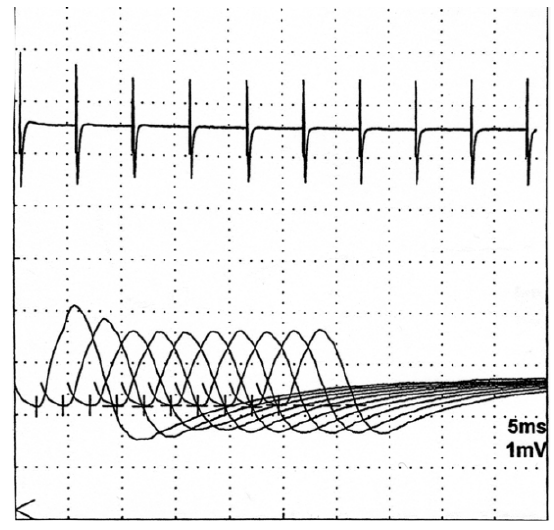
Figure 4. Milder changers in nasalis muscle of another patient, decrement 27.5%.